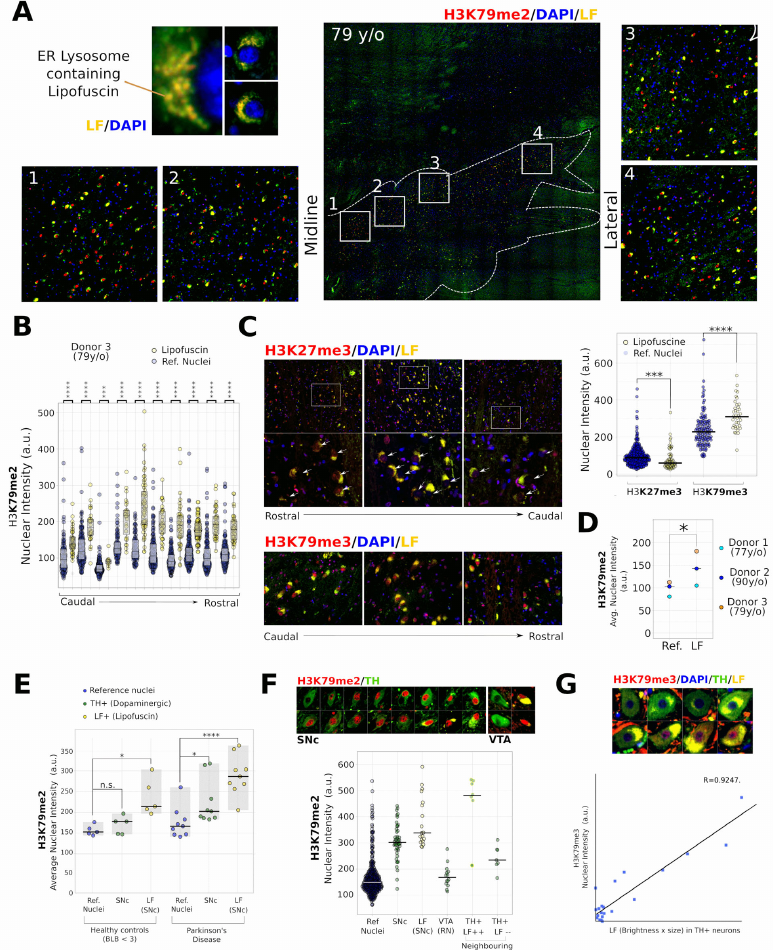
Figure 1. Increased H3K79me2 associates with Lipofuscin in the human midbrain. ( A ) Fluorescent image of typical red + green (yellow) autofluorescent lipid spheres containing accumulated dense protein (waste) structures in an ER-like morphology surrounding large nuclei (blue) (LF detail 40 × lens, 10 × lens overview, 1–4: 10 × lens). Lipofuscin accumulation in a midbrain area overlapping with the SNc of a 79-year-old male with only minor loss of pigmented neurons, no Lewy body pathology (Supplementary Table S1), and no clinical PD but low TH levels (almost absent visible TH staining). White lines indicate the area with major LF accumulation. (A1–A4) Magnification boxes in numbered 1–4 representing regions from medial to lateral showing the correlation between LF- autofluorescent neurons and H3K79me2 nuclear staining. Nuclear staining of DAPI (blue), H3K79me2 (red), and in LF (autofluorescence green/red-yellow). ( B ) Quantification of sections from rostral to caudal. Each comparison shows LF-associated nuclei and automatically selected surrounding reference nuclei from a single merged image. Mann–Whitney statistical tests were performed to compare the median of LF-associated nuclear H3K79me2 staining with those of the surrounding reference nuclei for each photo. ( C ) Selection of images from a rostral to caudal series showing H3K79me3 ( bottom ), but not H3K27me3 ( top ), correlating to nuclei surrounded by LF. The upper right diagram shows the quantification of H3K27me3 and H3K79me3 of adjacent coupes in LF and surrounding reference nuclei. Mann–Whitney statistical tests were used for median (of average per nuclei) levels of H3K79me3 and H3K27me3 surrounding nuclei in adjacent coupes. (10 × lens overview, 40 × lens detail) ( D ) Comparison between average H3K79me2 levels of reference and LF-associated nuclei measured from combined rostral and caudal midbrain sections of three aged human donors. Paired Student’s t-tests was used to test if the average nuclear H3K79me2 levels increased as compared to surrounding reference nuclei in three different donors. ( E )